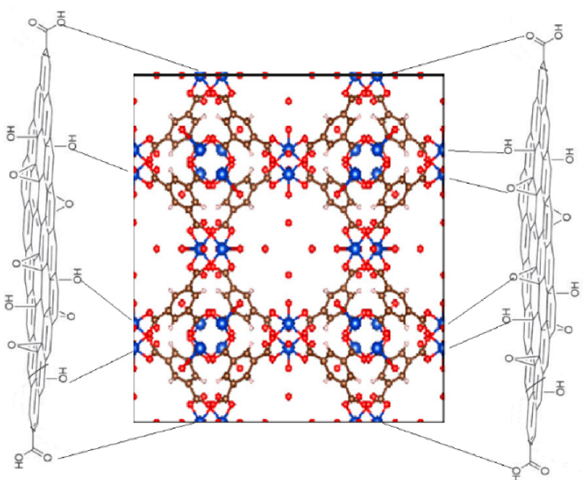
Figure 5. Scheme of the location of copper trimesinate between graphene layers in the composite. The Cu atoms are shown in blue; O atoms, red; C atoms, brown; H atoms, pink.